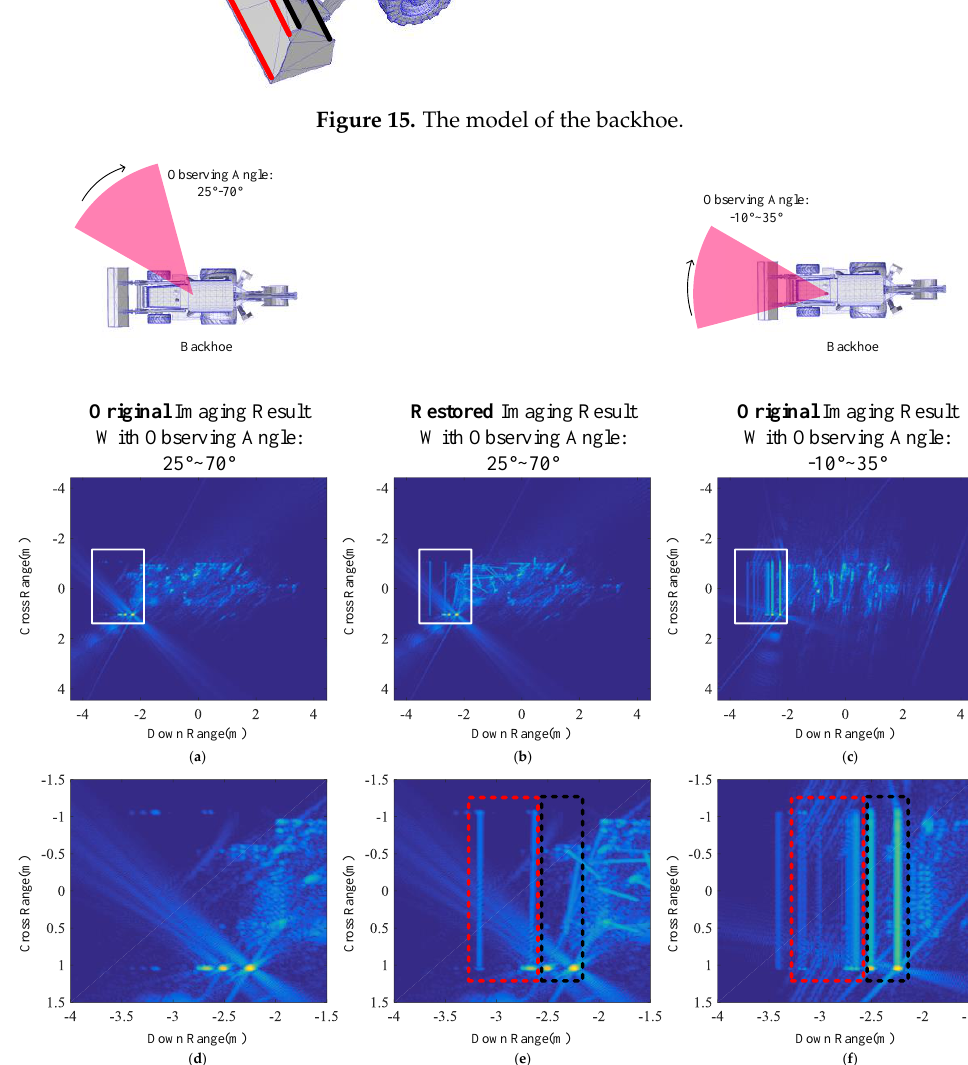
Figure 16. Imaging results of the backhoe data. ( a ) Image corresponding to the look angles ranging from 25° to 70°. ( b ) The restored result of (a). ( c ) Image corresponding to the look angles ranging from − 10° to 35°. ( d ) Portion of (a). ( e ) Portion of (b). ( f ) Portion of (c).